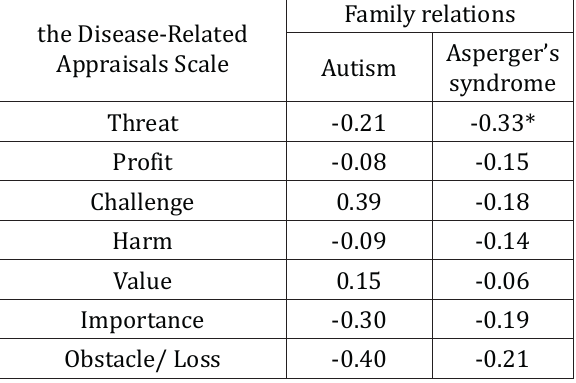
Table 1. Correlation coefficients calculated between the assessment of relations in the family and the scores on the Disease-Related Appraisals Scale in the group of mothers of children with autism and with Asperger's